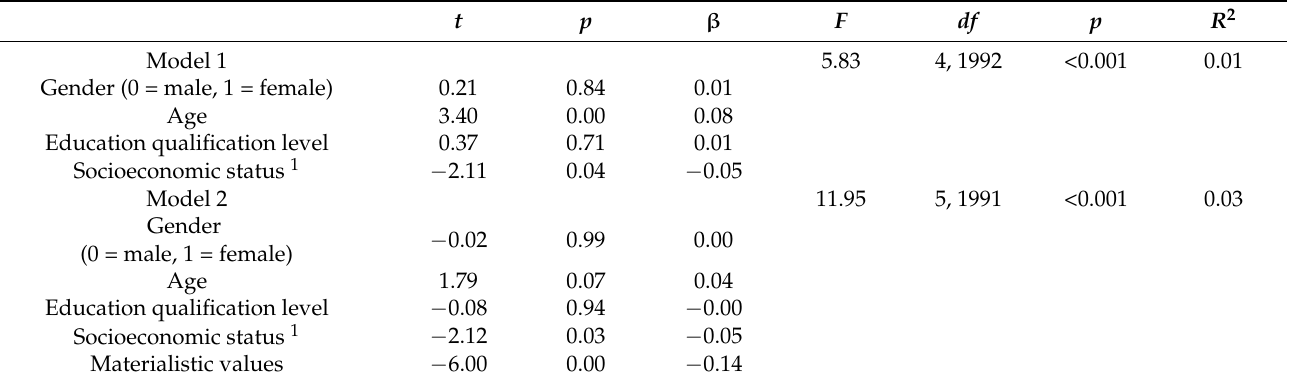
Table 5. Linear Regression Analysis examining the influence of the materialism on flow